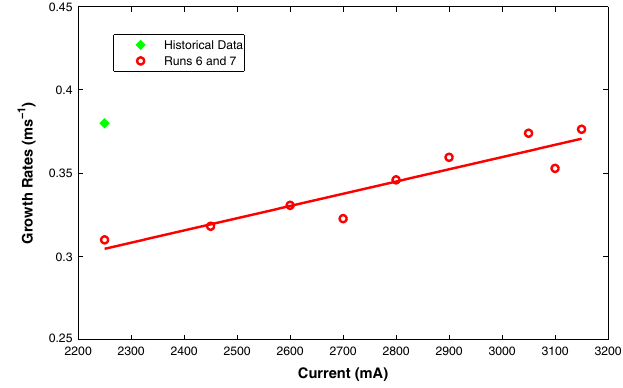
FIG. 4. (Color) LER HOM-driven coupled-bunch modal growth rates for modes 790–810. Data from various runs is scaled by the number of installed rf cavities for consistency (from